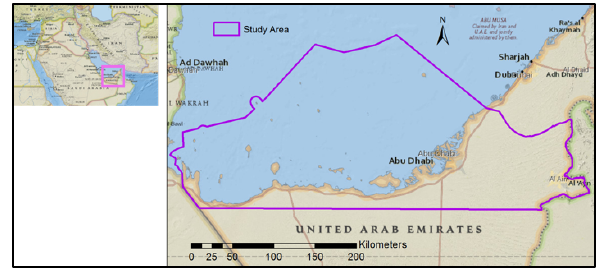
Figure 1: Study area The map of UAE mean wind speed at 50m extracted from the National Renewable Energy Laboratory shown in figure 2, indicates that areas offshore the Emirate of Abu Dhabi experience wind speeds in the range of 5-6 m/s, exceeding the wind speed threshold for power generation (Baban and Parry 2001), indicating good potentiality for offshore AD to construct feasible wind farms.